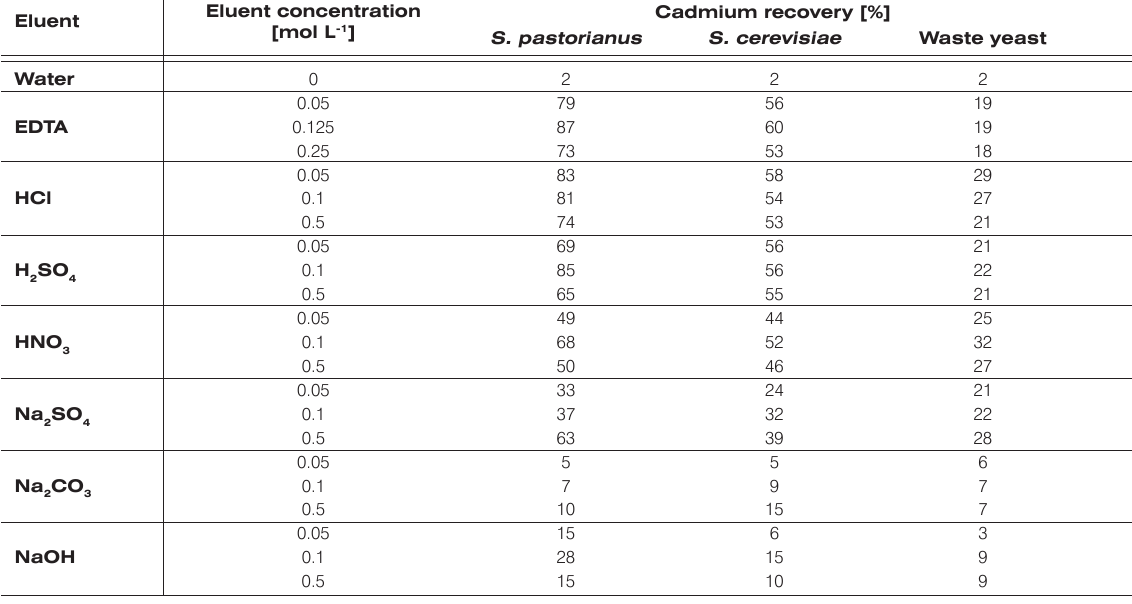
Table 3. The cadmium desorption efficiency of 5 mL of various eluents (liquid to solid ratio of 0.01 L g -1 ). Eluent concentration Eluent [mol L -1 ]